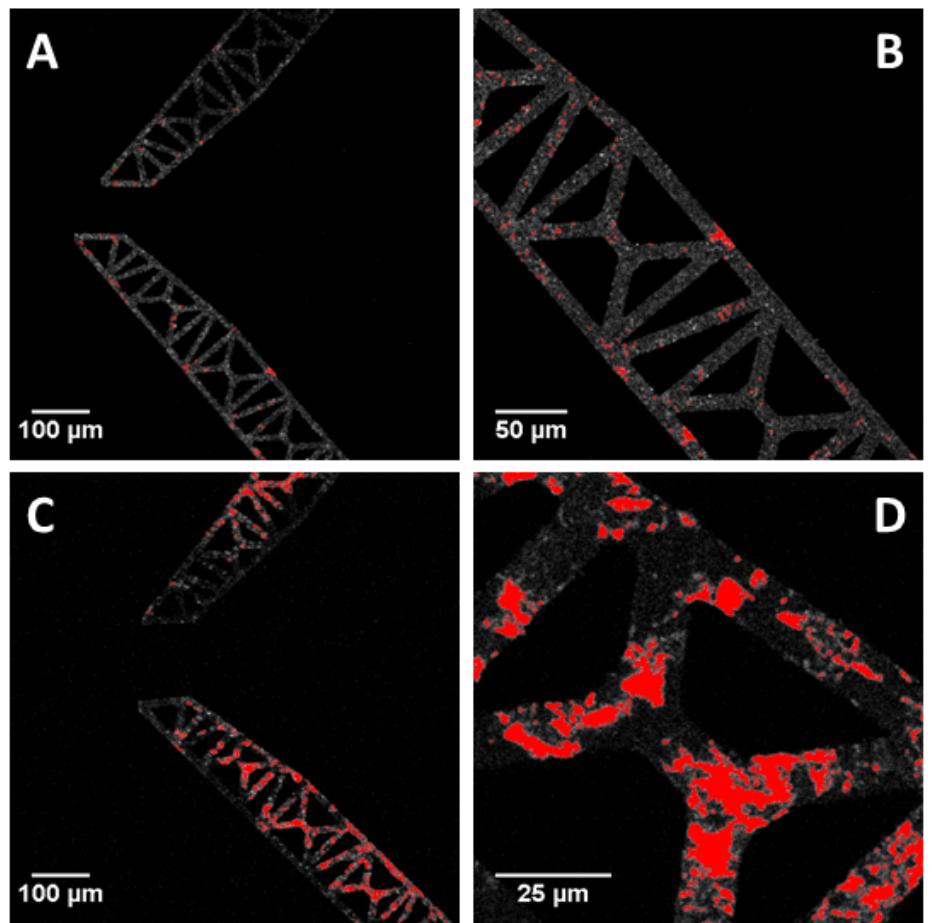
Figure 11. Images of BSA-TAMRA (red regions) adsorbed on the aluminum side of microgrippers ( A and B ) or on the silicon side of microgrippers ( C and D ), presented with different magnifications. BSA was incubated for 30 min at 0.2 mg/mL, at room temperature. Microgrippers are highlighted in